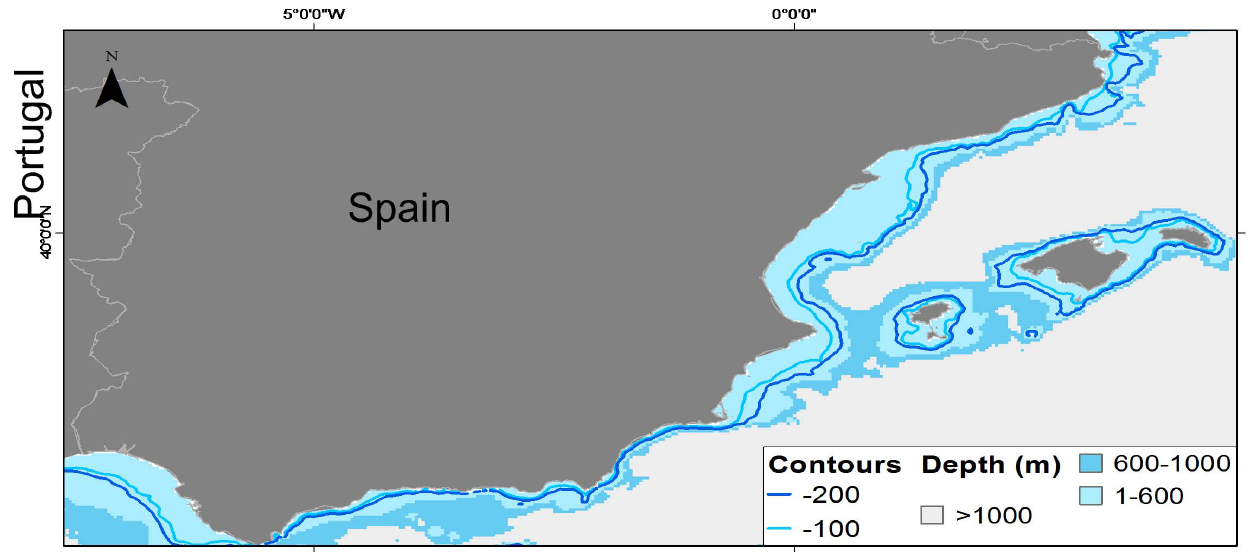
Figure 4. Spatial representation of mean depth and range values between past (mean =100, range =1–600 m) and present (mean =200, range =1–1000 m) fishing activities.